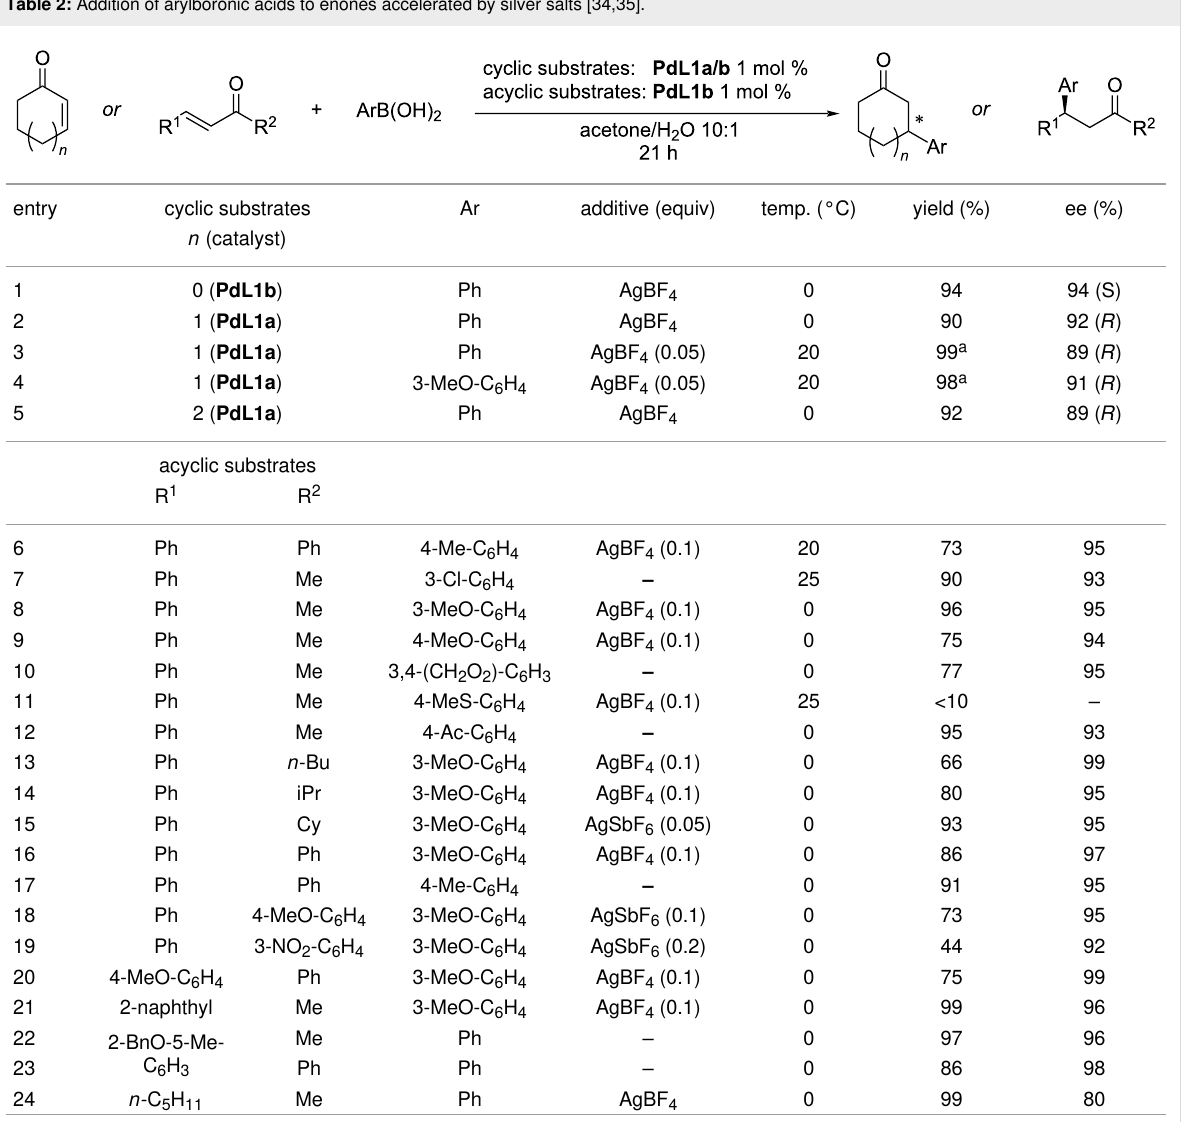
a Reaction time: 48